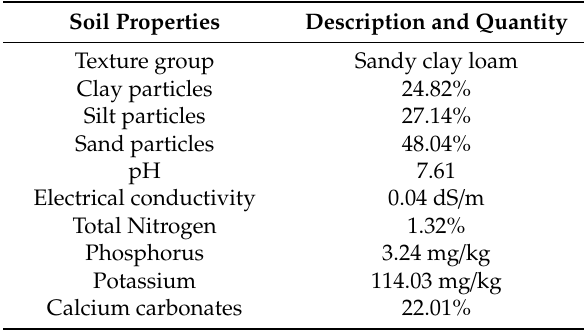
Table 2. Soil physical and chemical properties of the research farm at 30 cm